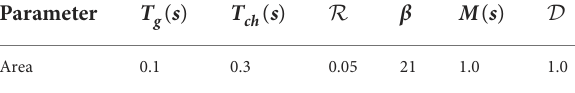
TABLE 1 System parameters.